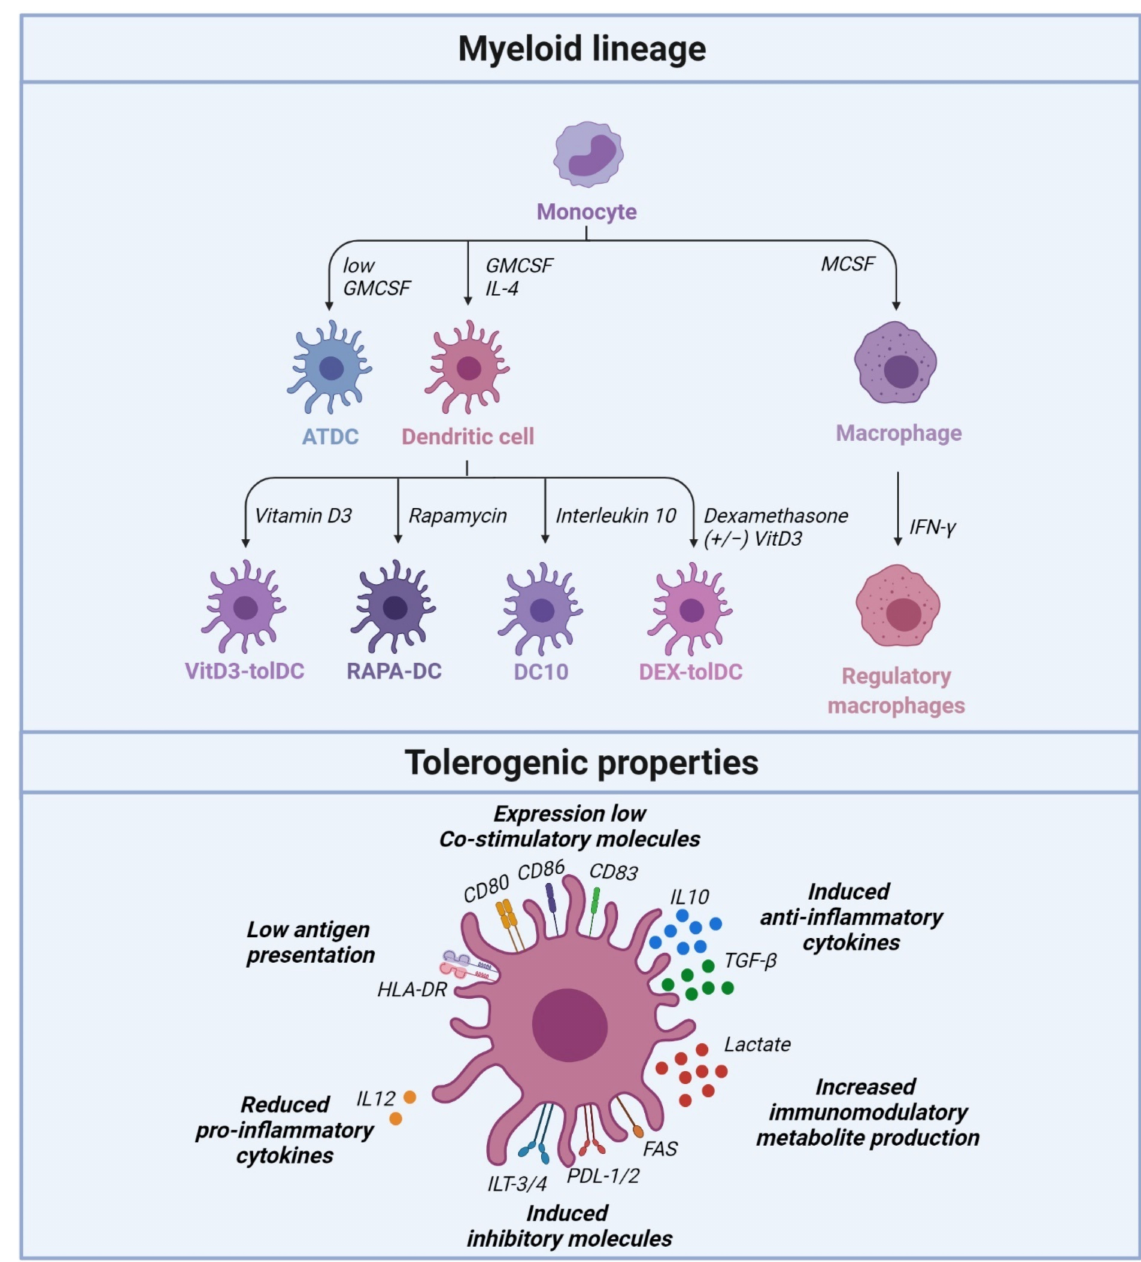
Figure 1. Overview of human tolDC generation by exposing blood monocytes to standard stimulation of granulocyte- macrophage colony-stimulating factor (GMCSF) and interleukin 4 (IL-4), plus additional growth factors, cytokines and pharmacological agents. Several strategies have been used to prepare clinical-grade, monocyte-derived tolDCs, where the stimuli, i.e., vitamin D3, rapamycin, dexamethasone and interleukin-10, have been extensively studied. These stimulated tolDCs, i.e., vitamin D3-tolDC (VitD3-tolDC), rapamycin-DC (RAPA-DC), interleukin-10 DC (DC10), dexamethasone tolDC (Dex-tolDC) and autologous tolDC (ATDC), have overlapping tolerogenic properties. TolDCs have low expression of costimulatory molecules (CD80, CD86 and CD83), induce immunosuppressive cytokines (like interleukin (IL)-10 and transforming growth factor (TGF)- β ), induce inhibitory molecules, express a low antigen presentation molecules (Human leukocyte antigen (HLA)-DR) and lower secretion of interleukin (IL)-12. Created with